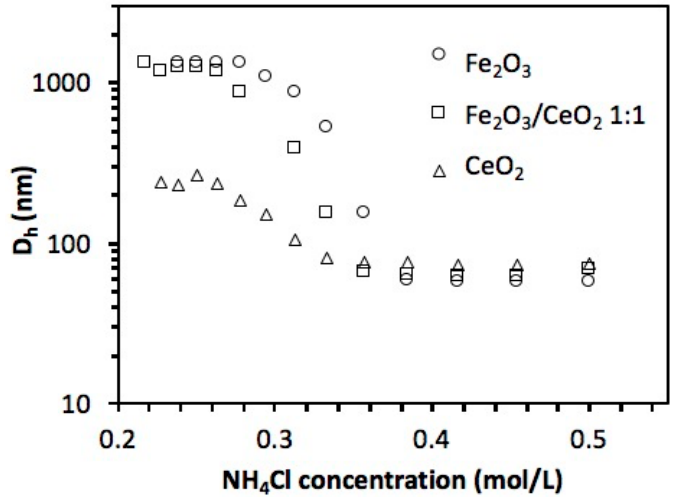
Figure 2. Hydrodynamic diameter versus ionic strength for mixture of PTEA 11K -b-PAM 30K with Fe 2 O 3 (circles), CeO 2 (triangles), and a mixture of Fe 2 O 3 and CeO 2 (squares) with the ratio 1:1.